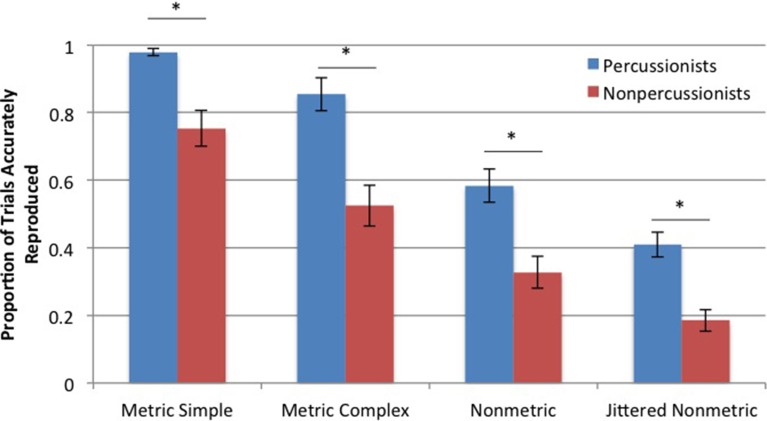
Mean proportions of accurately reproduced trials in the rhythm reproduction task. Error bars indicate ± 1 s.e.m. *Indicates p < 0.001.